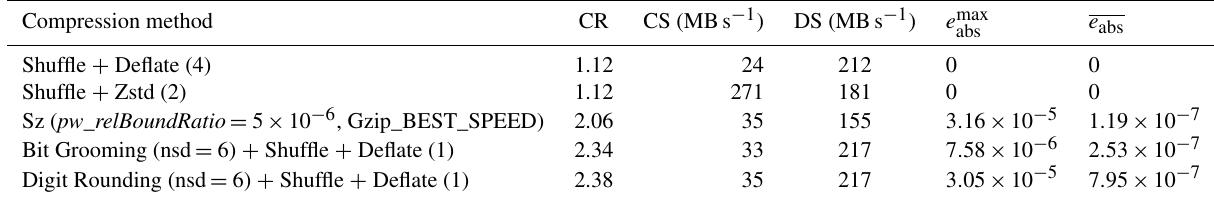
Table 10. Compression results for the height variable in the simplified simulated SWOT L2_HR_PIXC pixel cloud product.